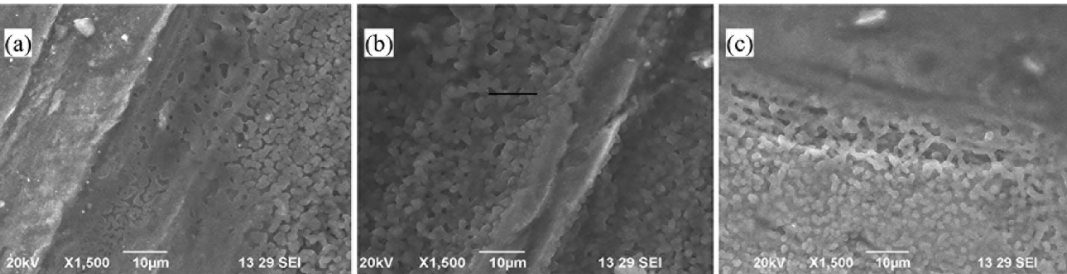
Figure 5: SEM images of (a) advancing side, (b) stir zone and (c) retreating side Al7020 joint with 10µ zinc interlayer.